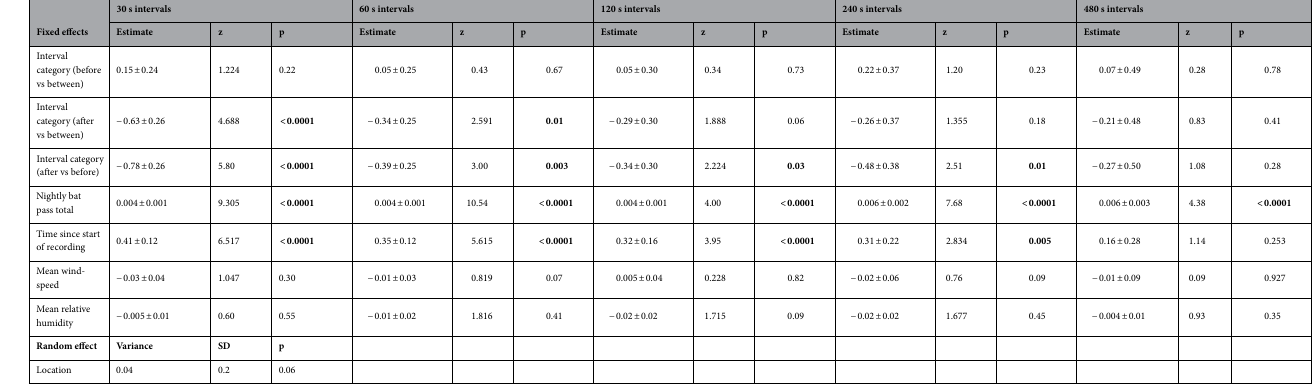
Table 1. Parameter estimates (± 95% confidence intervals), z- and p-values for fixed effects included in linear models relating bat activity to interval type (before, after and between train passes), controlling for effects of nightly bat pass total (total bat passes recorded during inter-train gaps per 3.5 h recording period), time since start of recording, and mean windspeed/relative humidity during the recording period. Also, variance standard deviation and p-value of random effect used to account for repeated measures within locations for the 30 s interval model (see Methods). For the 30 s interval model, all parameters are averaged across the best fitting linear mixed-effect models (see “Methods”), except for the random effect variance, standard deviation and p-value which were extracted from the full model.